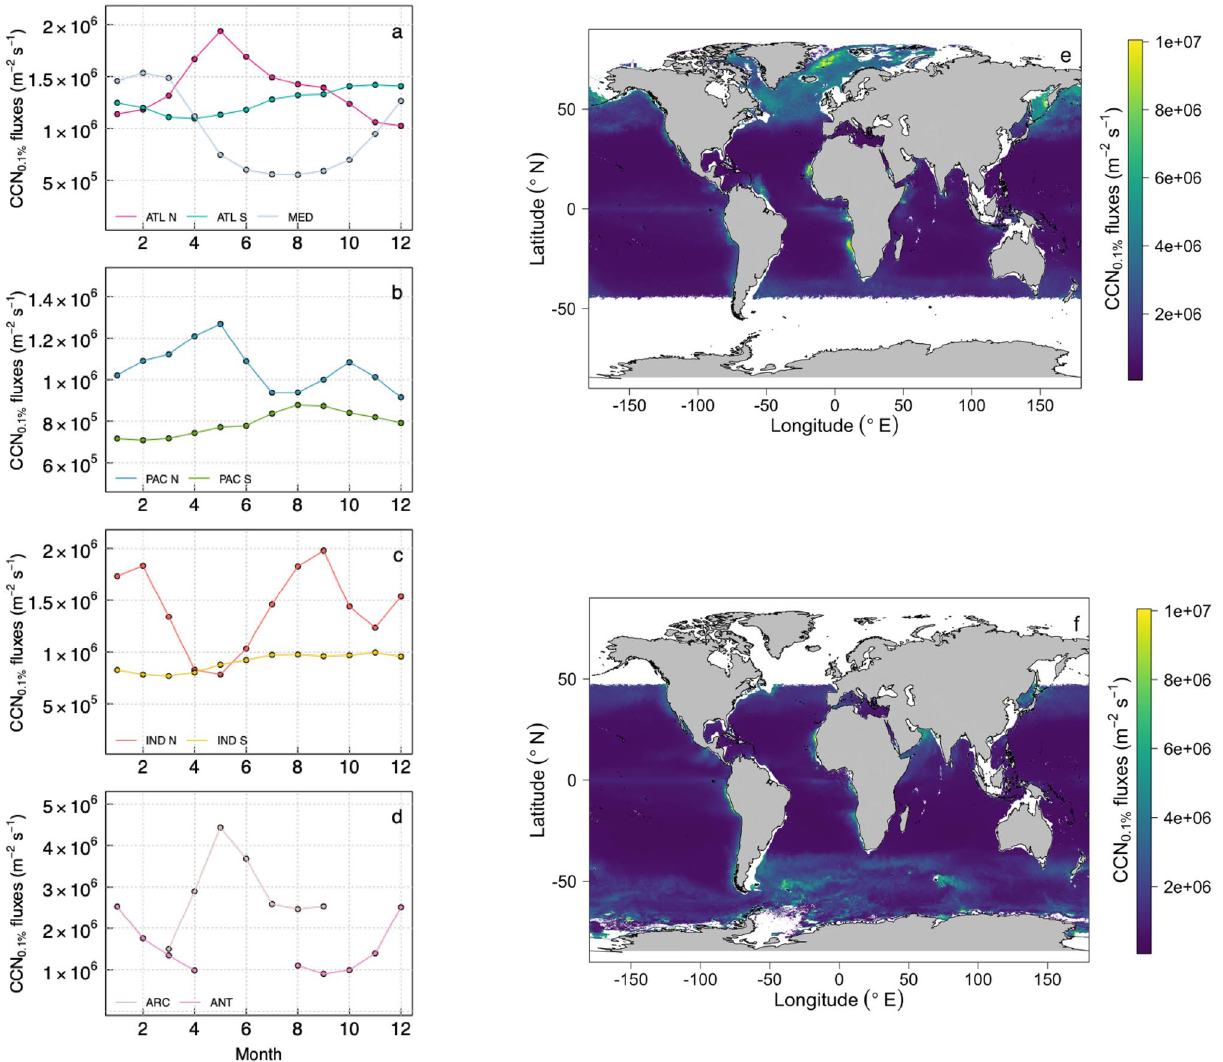
Figure 4. Global CCN 0,1% emission fluxes (m −2 s −1 ) computed for a 15 °C temperature from satellite-based nanoplankton cell abundance in June (e) and December (f) . CCN fluxes were computed using Eq. (1), and assuming that CCN 0,1% is equal to SSA 100 . Median annual trends are represented for the different oceanic basins (a) ATL N: North Atlantic, ATL S: South Atlantic, MED: Mediterranean Sea; (b) PAC N: North Pacific, PAC N (South Pacific), (c) IND N (North Indian Ocean), IND S (South Indian Ocean), (d) ARC (Arctic Ocean), ANT (Southern Ocean). Maps provided (e,f) were created using R version 3.4.2. (https ://www.R-proje